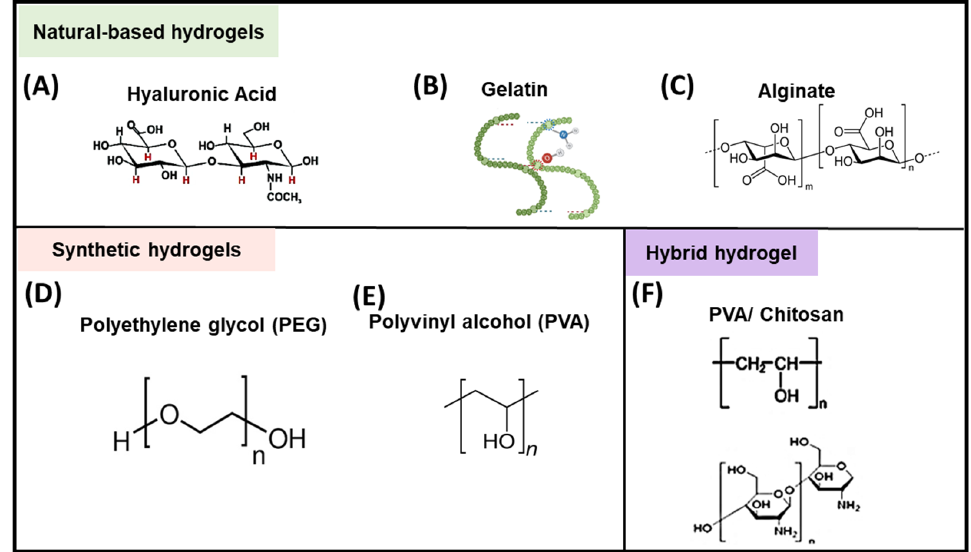
Figure 2. Different types of immunomodulating hydrogels. ( A ) Structural formula of hyaluronan disaccharide unit, ( B) Molecular structure of gelatin (redrawn from the original article [57]), ( C ) Molecular structure of alginate, ( D ) Molecular structure of PEG, ( E ) Structural formula of PVA ( F ) Molecular structure of hybrid hydrogel composed of PVA/Chitosan.